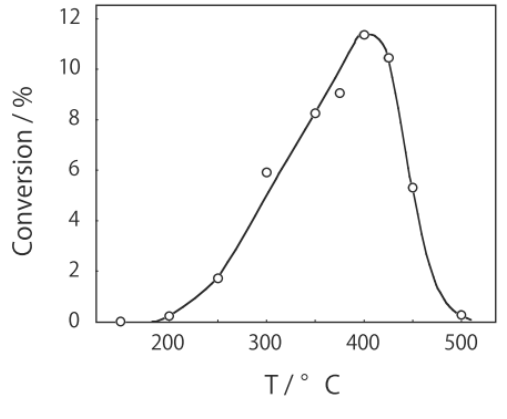
(H O) [(Mo Cl )Cl ]·6H O at 3 h after the start of the reaction. Following the activation 3 2 6 8 6 2